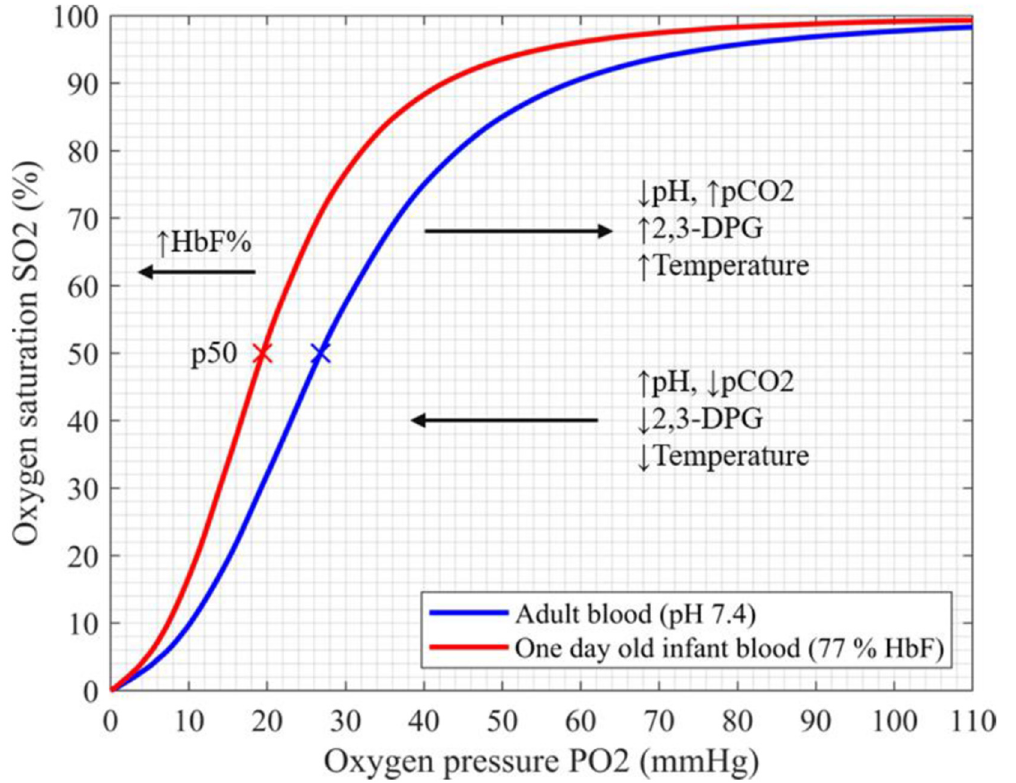
Figure 1. Oxyhemoglobin dissociation curve of fetal and adult hemoglobin shows the relationship between pO2 and SO2. For the saturation of 50%, the corresponding pO2 values (p50) are indicated (×). The factors that change the hemoglobin affinity for oxygen are indicated. HbF (red), fetal hemoglobin; pCO2, partial pressure of carbon dioxide; 2,3-DPG, diphosphoglycerate.